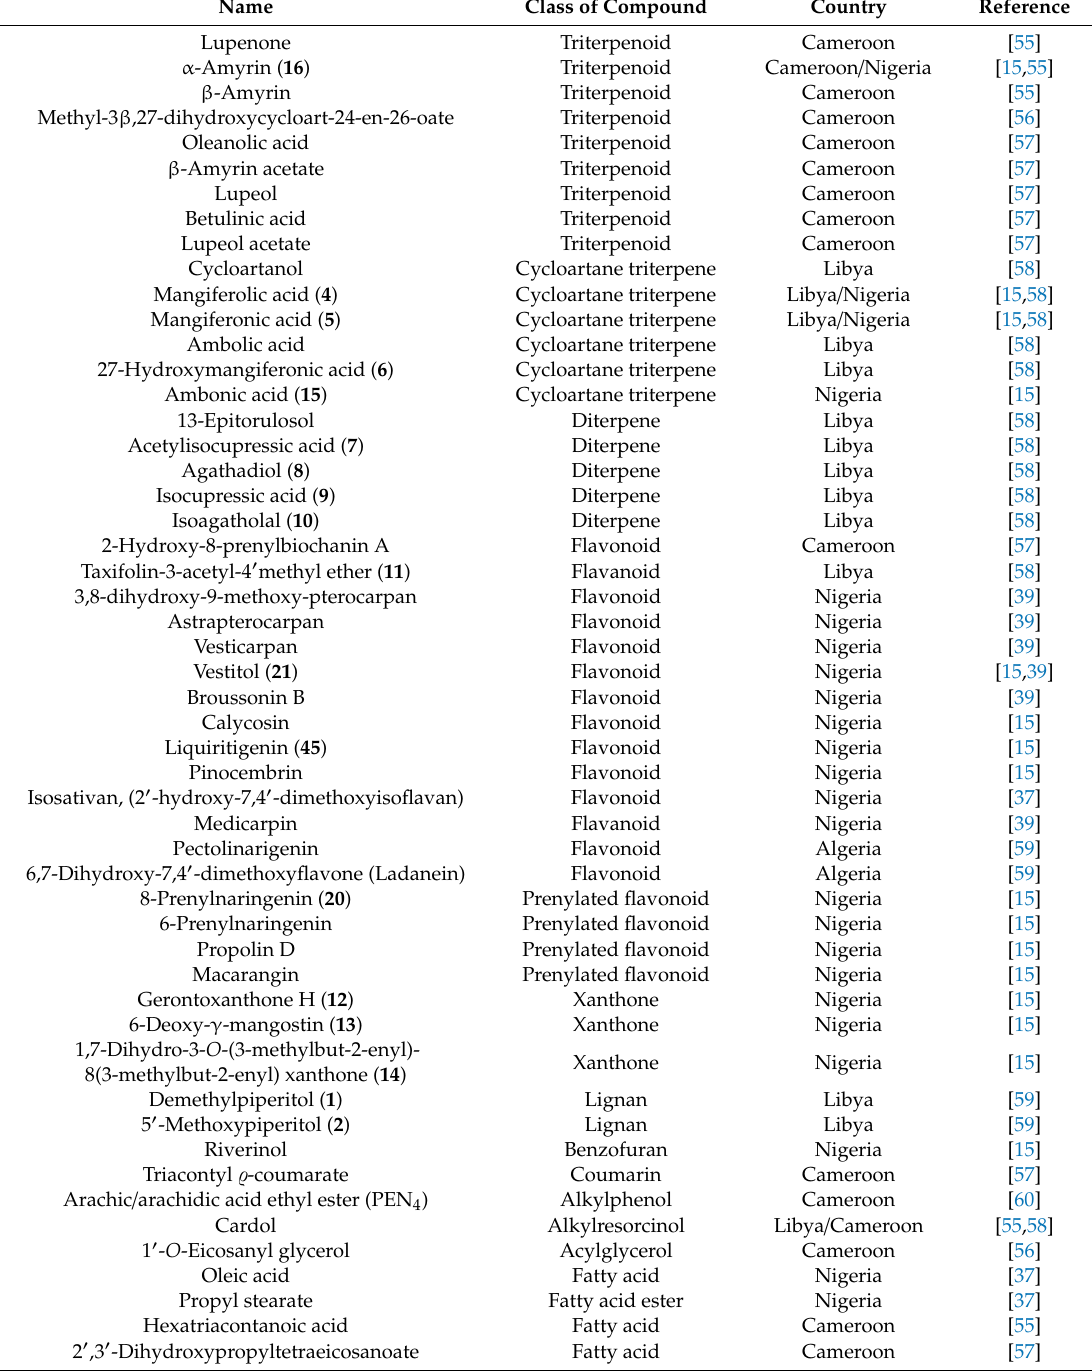
Table 1. Some compounds isolated from African propolis between 2015 and